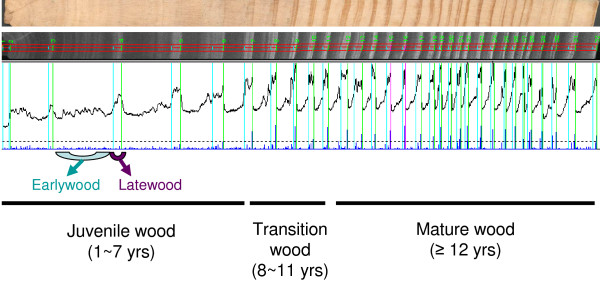
A wood core and SilviScan profile of wood density for a 32-year-old radiata pine tree. The cross section of wood core sampled at 1.3 m height shows the annual change in width and colour of earlywood and latewood within each ring. Wood density is the most important wood trait for the sawmill timber industry. SilviScan profiling for wood density of radiata pine revealed the distinct characteristics of juvenile wood, particularly juvenile earlywood, compared to transition and mature wood. SilviScan analysis was performed in the method of Evans, et al, 2000 [78].